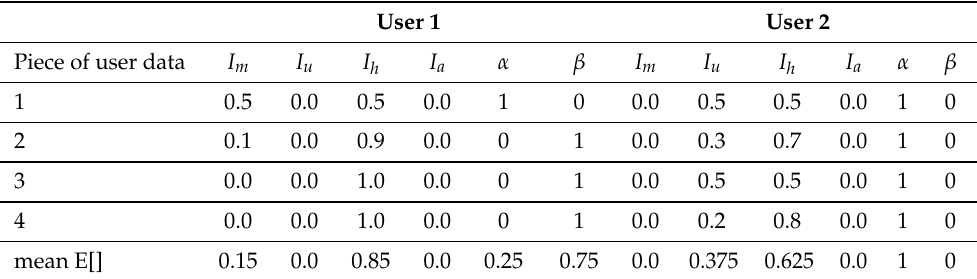
Table 9. Example of Lacan’s and Bion’s indices